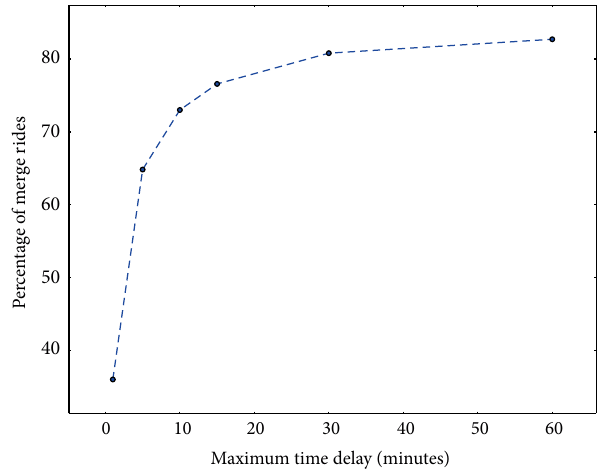
Figure 9: Potential of ride-sharing utilization, measured as the percentage of potentially merged rides (averaged over all sub- networks), as a function of maximal delay agreeable by the passengers. The figure is based on the result presented